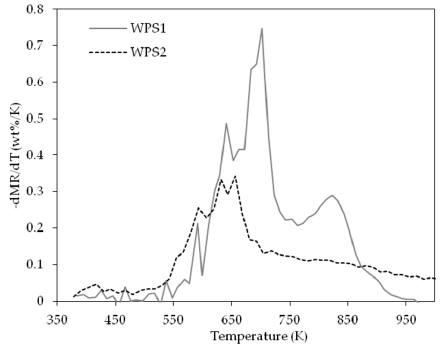
Figure 2. DTG curve of − dM R /dT vs. T for WPS1 and WPS2 in N 2 : Pre-heating at 378 K for 20 min, heating rate of 10 K/min, sample weight of 20